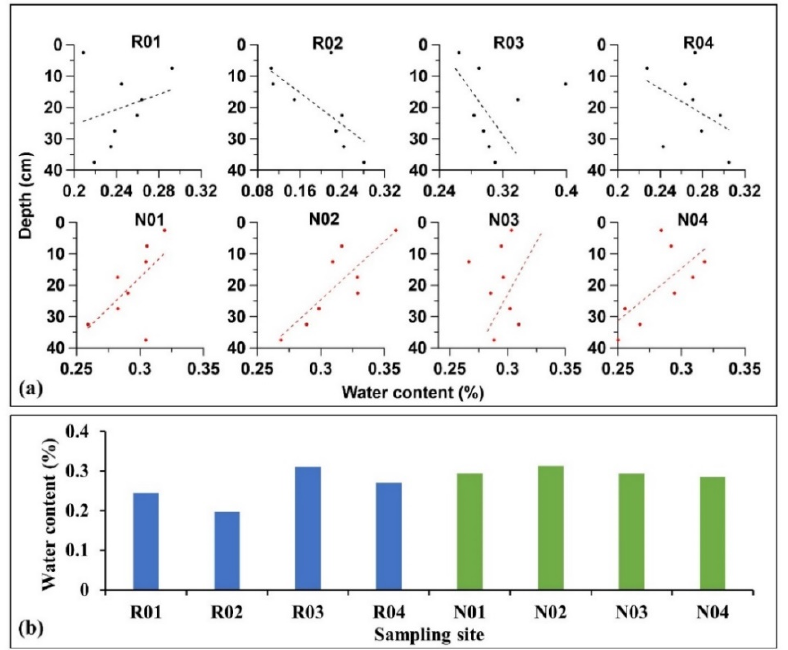
Figure 5. Changes in soil water content with depth at each sampling site. ( a ) The change in soil water content with depth; ( b ) the mean soil water content at each sampling site.